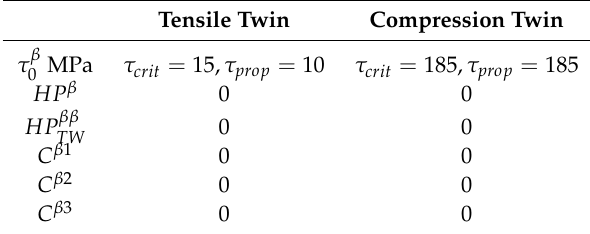
Table A2. Parameters for hardening evolution of